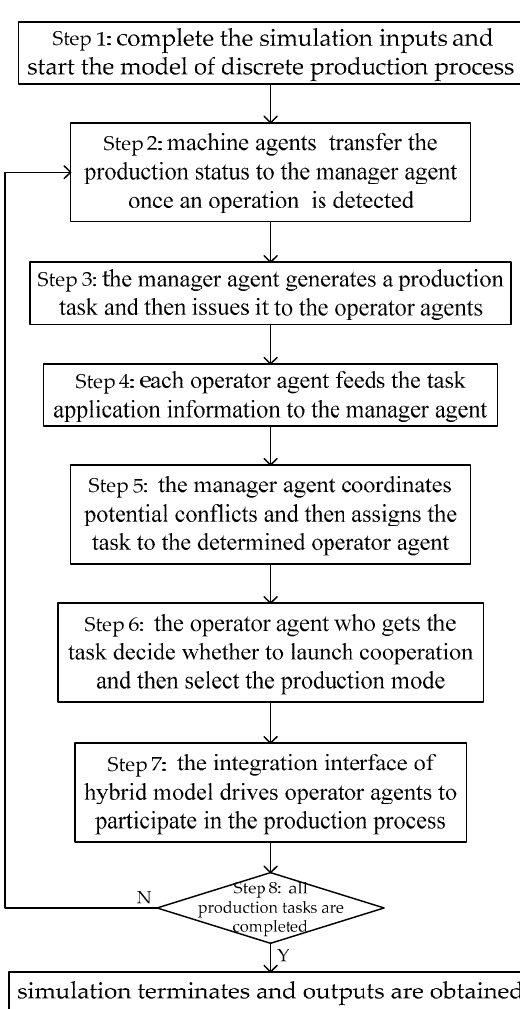
Figure 2. Flowchart of the simulation logic.